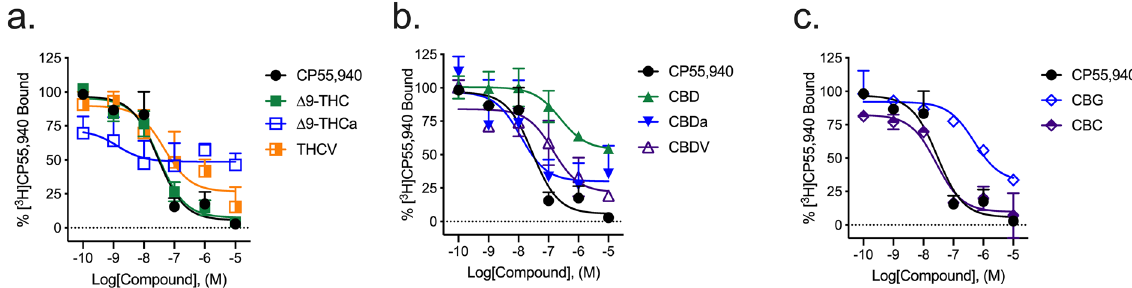
Figure 5. [ 3 H]CP55,940 displacement from hCB2R CHO cell membranes. Compound activity was quantified for [ 3 H]CP55,940 binding in CHO cells stably expressing hCB2R and treated with 0.1 nM–10 µM ( a ) THC-like compounds; ( b ) CBD-like compounds; or ( c ) CBG, or CBC. Data were fit to a variable slope (4 parameter) non- linear regression in GraphPad (v. 8). n ≥ 6 independent experiments performed in duplicate. Data are expressed as mean ± SEM. K i and E min are reported in Table 1.